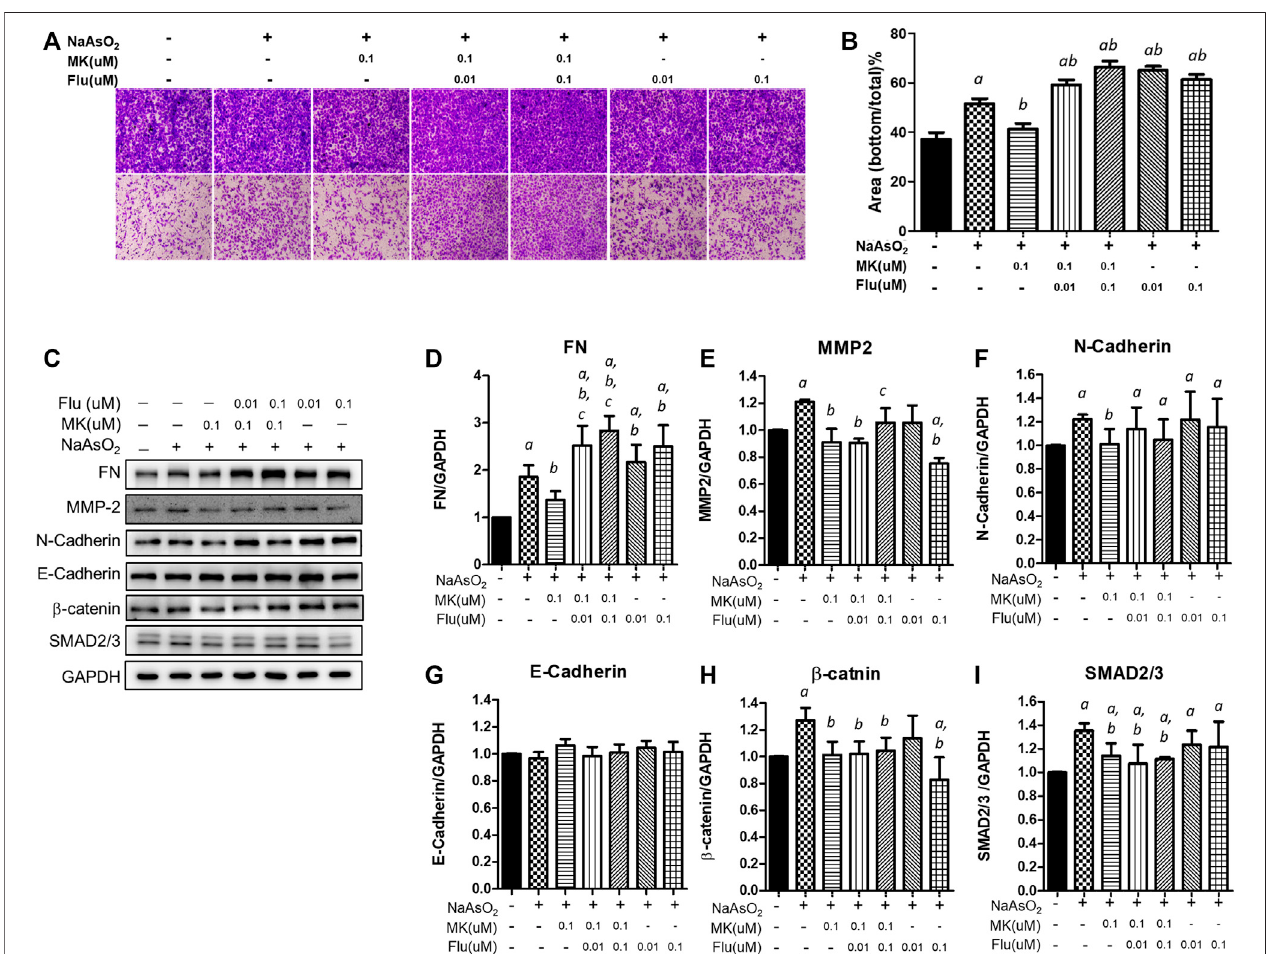
FIGURE 5 | Effect of the combination of montelukast and fl uticasone on NaAsO 2 -induced cell migration of NHBE cells. Cells were pretreated with medications for 2 h and then arsenic was added. (A,B) After 24 h of incubation, the cells were trypsinized, plated onto the inner side of the Transwell chamber and incubated for 36 h. Themigratedcellswereanalyzedbytheratioofthebottom/totalofthecelloccupiedarea.Representativeimages(leftpanel)andthequantitative resultsareshown(right panel). (C – I) After 24 of incubation, the protein lysates were extracted and applied to western blot analysis. The representative image was shown in (C) , and the quantitative results were shown, respectively (D – I) . a : p < 0.05 compared with the vehicle control group. b : p < 0.05 compared with the NaAsO 2 group. c : p < 0.05 compared with the montelukast plus NaAsO 2